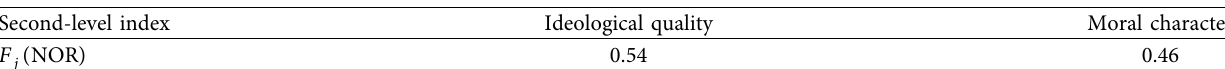
Table 12: F j (NOR) of ideological and moral